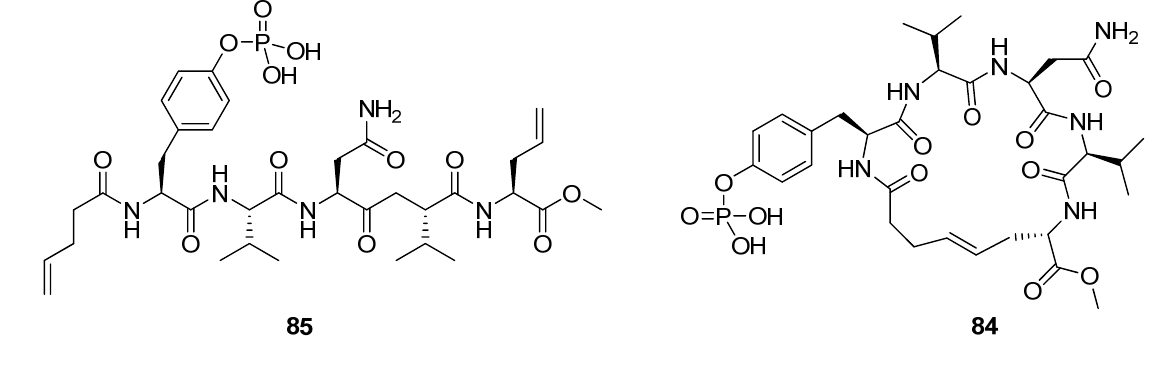
Figure 21. Cyclization of 85 does not improve the affinity for the SH2 domain of the Grb2 adapter protein, possibly because of an enthalpy-entropy compensation